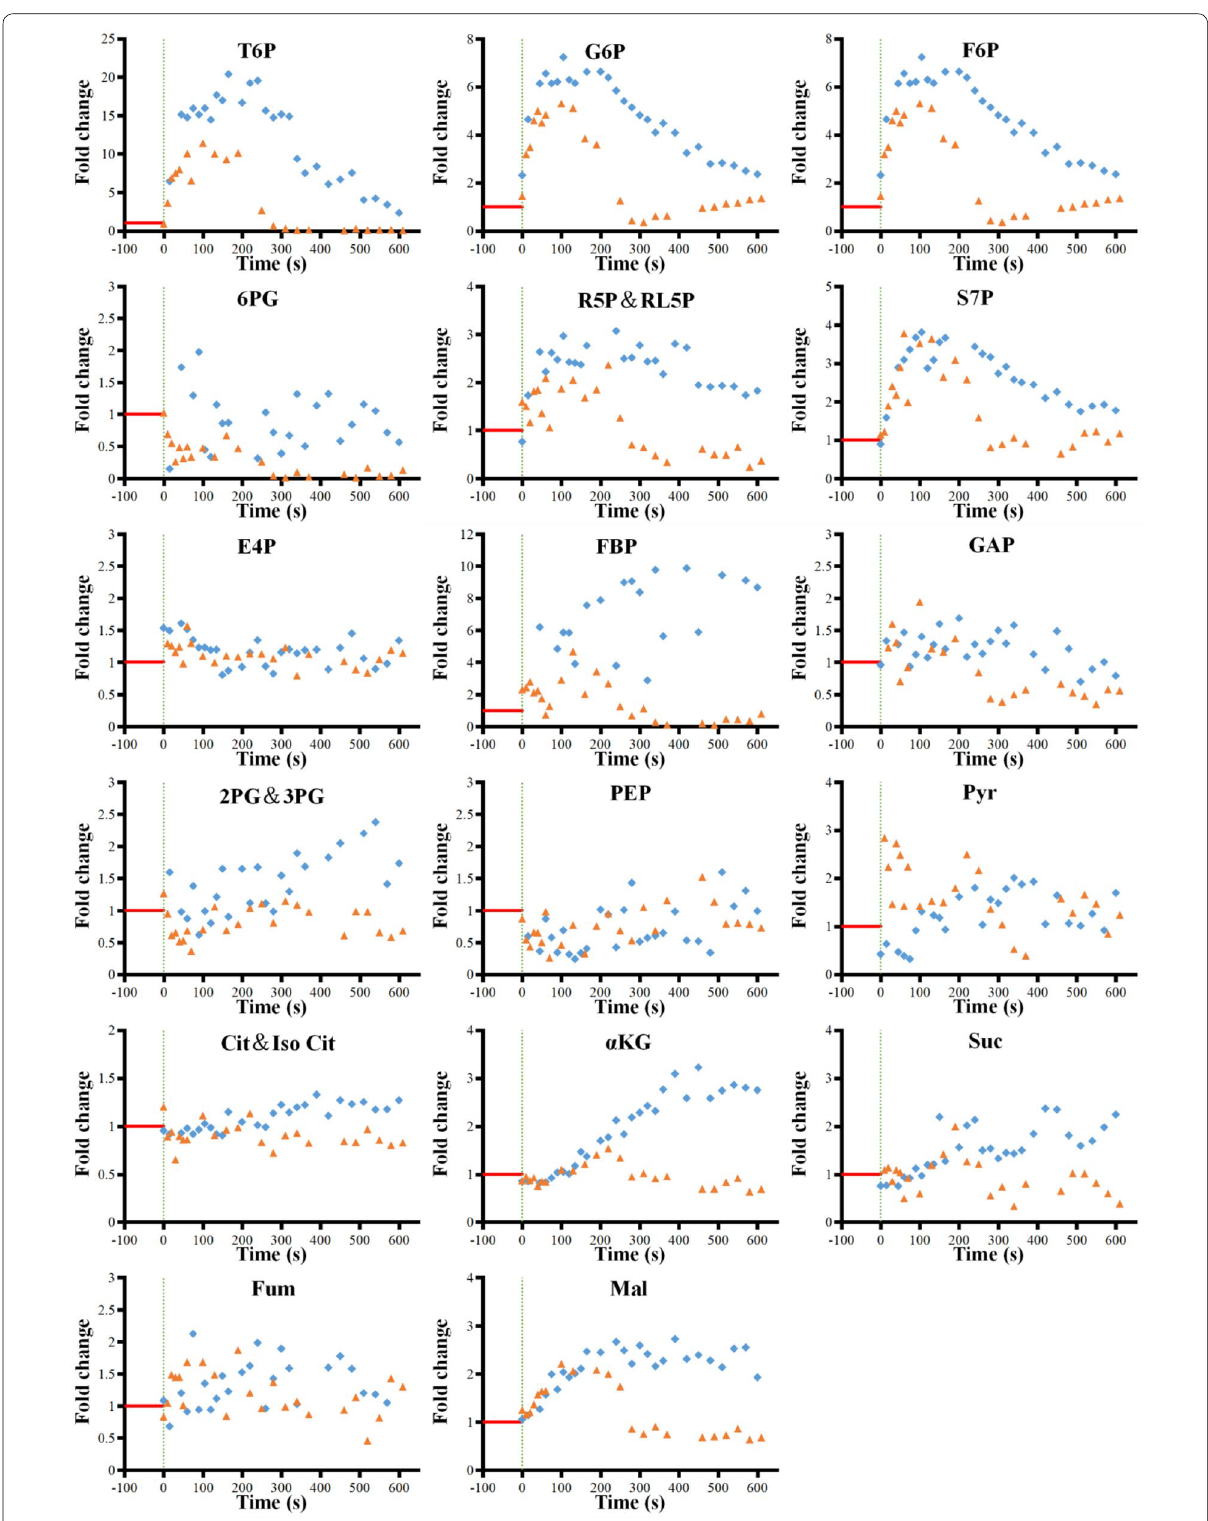
Fig. 5 Fold changes of intracellular central carbon metabolic intermediates during the first 10 min after the glucose pulses. Vertical hashed lines represent the start of the glucose pulse. The steady-state level is represented as red horizontal